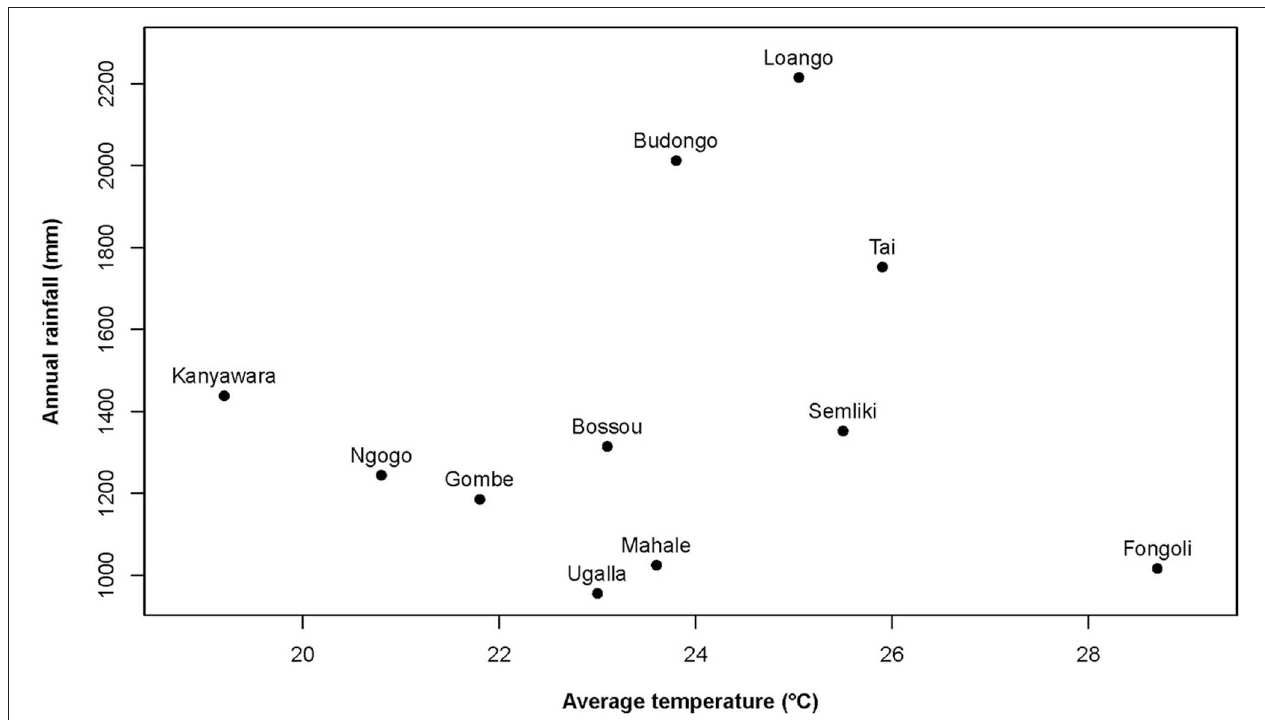
FIGURE 1 | Average annual temperature ( ◦ C) and annual rainfall (mm) for chimpanzee long-term research sites ( n = 10) (Data are derived from Head et al., 2011; Matsuzawa et al., 2011, this study; Lindshield, 2014; Piel et al.,